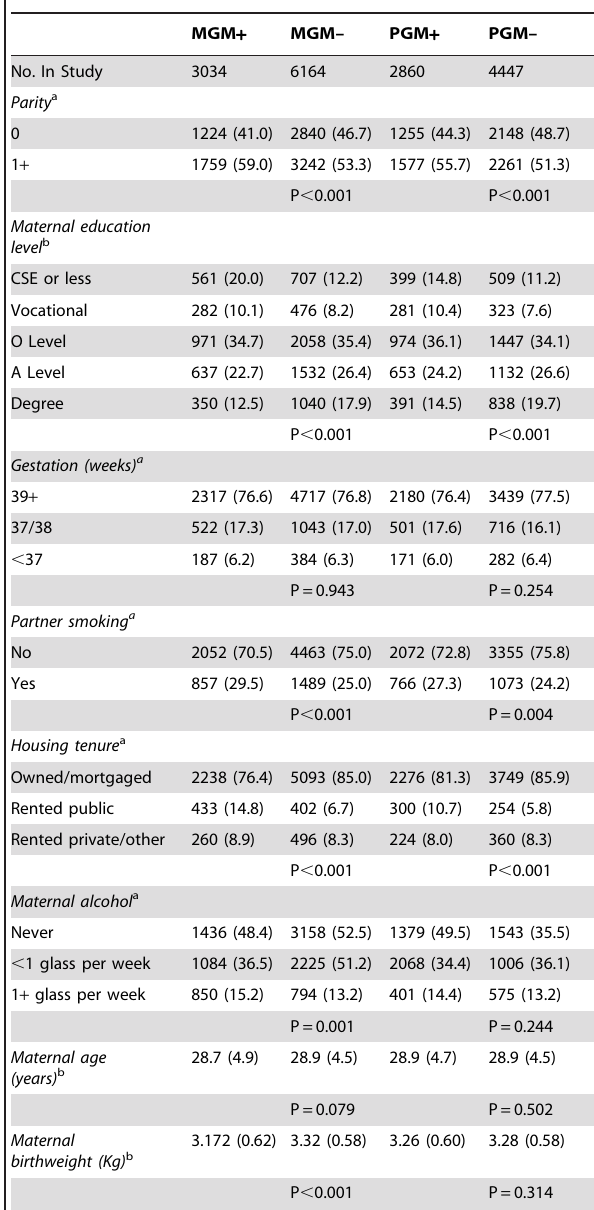
Table 2. The sample of the mothers who did not smoke in pregnancy according to the demographic variables related to each of the MGM and PGM